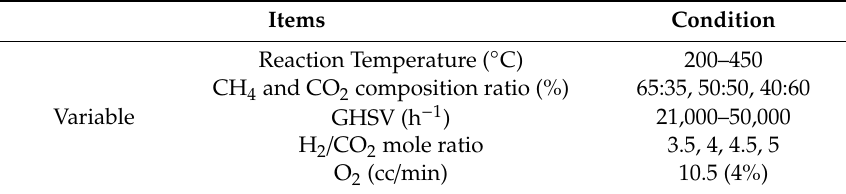
Table 1. Experimental condition for CO 2 methanation reaction.